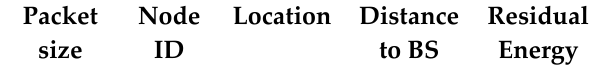
Figure 8. Format of data packet type_3.